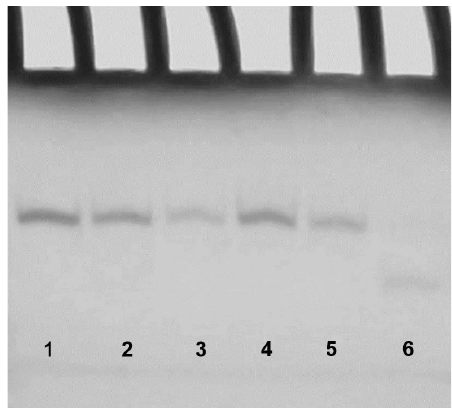
Figure 4. Polyacrylamide Gel Electrophoresis (PAGE) analysis of the T30923 analogues investigated. Lane 1: INT-M2; lane 2: INT-M6; lane 3: INT-M10; lane 4: INT-M14; lane 5: INT-nat; lane 6: TT-INT-nat. See Materials and Methods for experimental details.